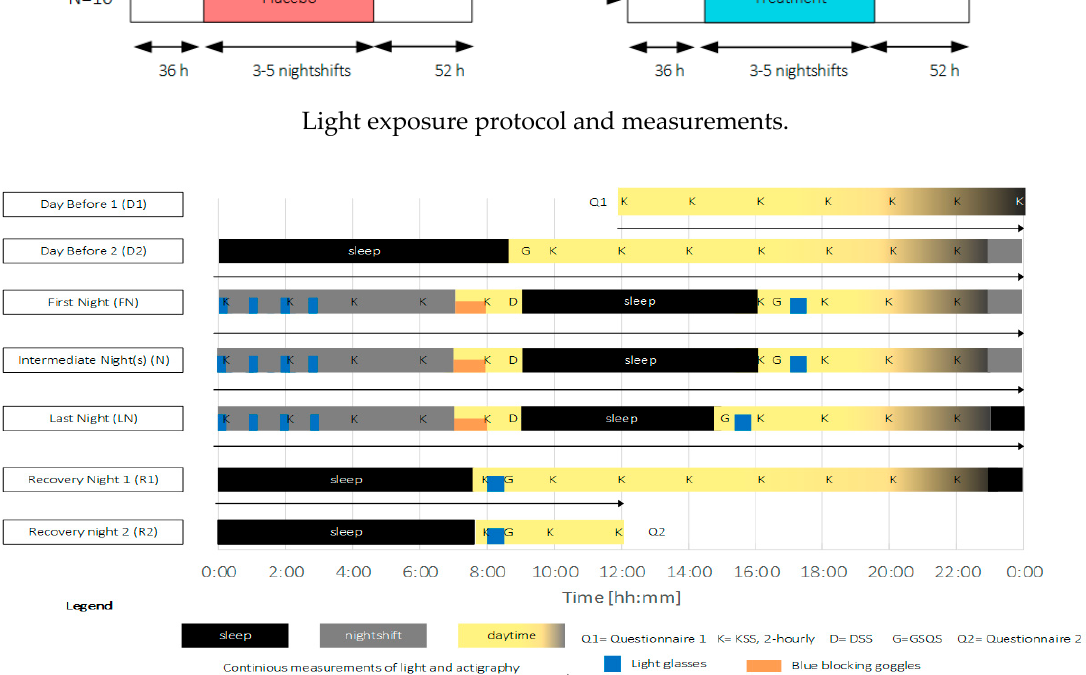
Figure 6. Top: overview of the study design, Bottom: exemplary light exposure protocol and measurement timings for a three-day measurement period. Participants started at 12:00 the day before (D1) the first nightshift, slept (black areas, D2) as normal and started their first nightshift (gray areas, end of D2). Light exposure (blue areas) was administered 4 × 15 minutes during nightshifts (FN, N, and LN) and for 30 minutes within 2 hours after awakening. During the morning commute home, blue-blocking goggles were worn (orange areas). The measurement period ended at 12:00 two days after the last nightshift (R2). KSS (K) was measured every two hours during the wake period. The driver sleepiness questionnaire (D) was filled in before going to bed after nightshifts. The GSQS (G) and sleep diary were filled in directly after sleep. Objective sleep and person-bound light exposure were continuously monitored during the entire measurement period.